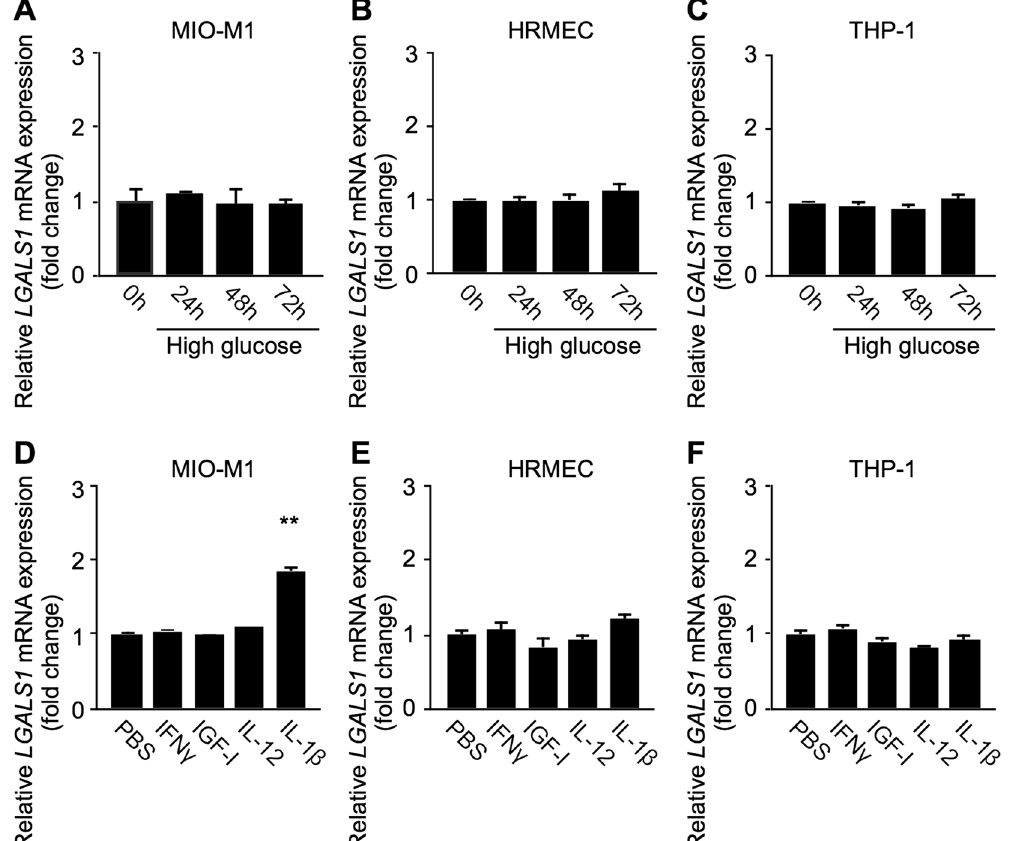
Figure 2. Induction of LGALS1 mRNA exclusively in IL-1 β -stimulated Müller glial cells. ( A–C ) MIO-M1 ( A ), HRMEC ( B ), and THP-1 ( C ) were incubated with the medium containing 30-mM glucose for indicated time intervals, and LGALS1 gene expression levels were analyzed. ( D–F ) MIO-M1 ( D ), HRMEC ( E ), and THP-1 ( F ) were treated with IFN- γ (100 ng/ml), IGF-I (100 ng/ml), IL-12 (10 ng/ml), and IL-1 β (10 ng/ml) for 24 hours, and LGALS1 expression was analyzed. ** p < 0.01 (n = 8 per